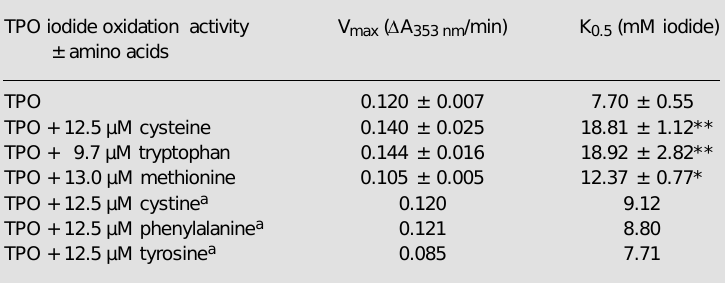
Figure 4 - Effect of some amino acids (50 µM) on diffuse toxic goiter-thyroid peroxidase (DTG- TPO) iodination activity. The io- dination of bovine serum albu- min (BSA) by DTG-TPO was measured in the absence or in the presence of tyrosine (open squares), tryptophan (filled squares), methionine (triangles) or cysteine